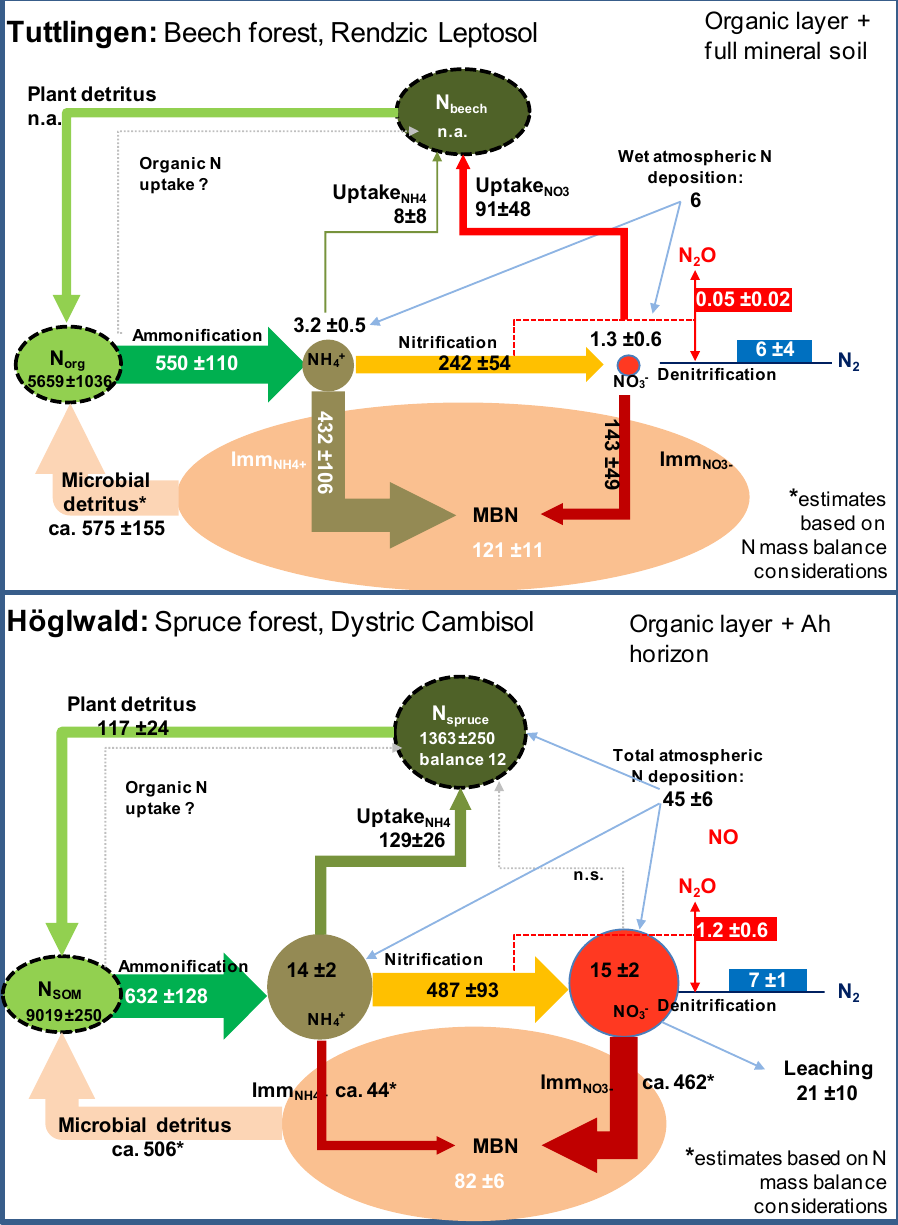
Figure 1. Gross nitrogen fluxes (kg N ha −1 year −1 ) and N pools (kg N ha −1 ) for two forest ecosystems in southern Germany: The Tuttlingen beech forest on marginal shallow Rendzic Leptosol soil, with low atmospheric N input (upper panel), and the Höglwald forest, a nitrogen-saturated spruce forest on a Dystric Cambisol soil and affected by chronic atmospheric N deposition (lower panel). Note that the thickness of the arrows relates to the size of the process rate, and the pool sizes of ammonium, nitrate and microbial biomass are reflected by the size of the pool signatures. It was not possible to provide size-scaled pool signatures for the N pools in soil organic matter (SOM) and plant biomass (both indicated with black dashed lines), because these pools exceed the labile soil N pools by several orders of magnitude. SOM does not include microbial biomass in this graph. For further information, see text. Ammonium and nitrate uptake was estimated for both forest ecosystems by multiplying the uptake capacities by the fine root biomass